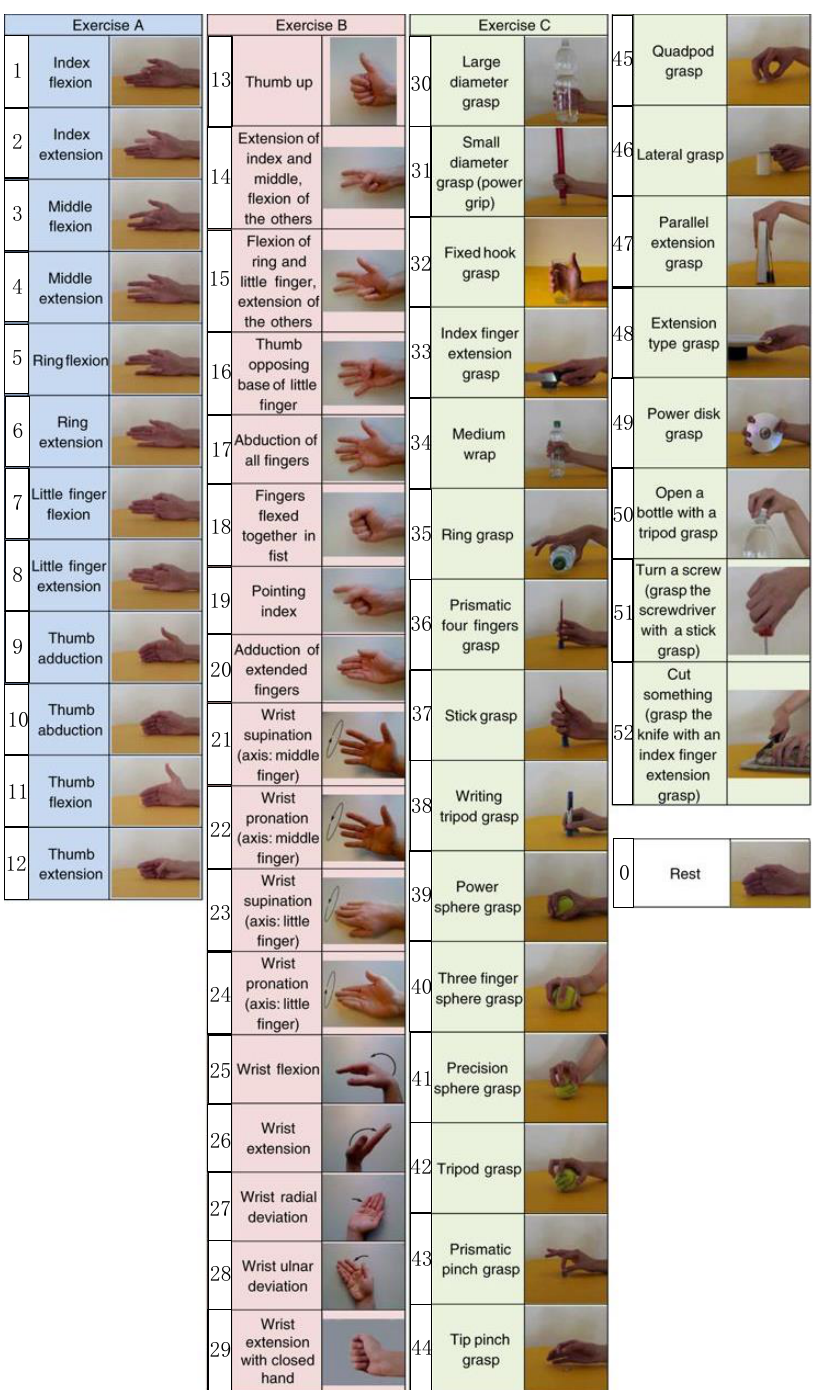
Figure A1. Hand gestures of the NinaPro database. Modified from [34] licensed under a Creative Commons Attribution 4.0 International